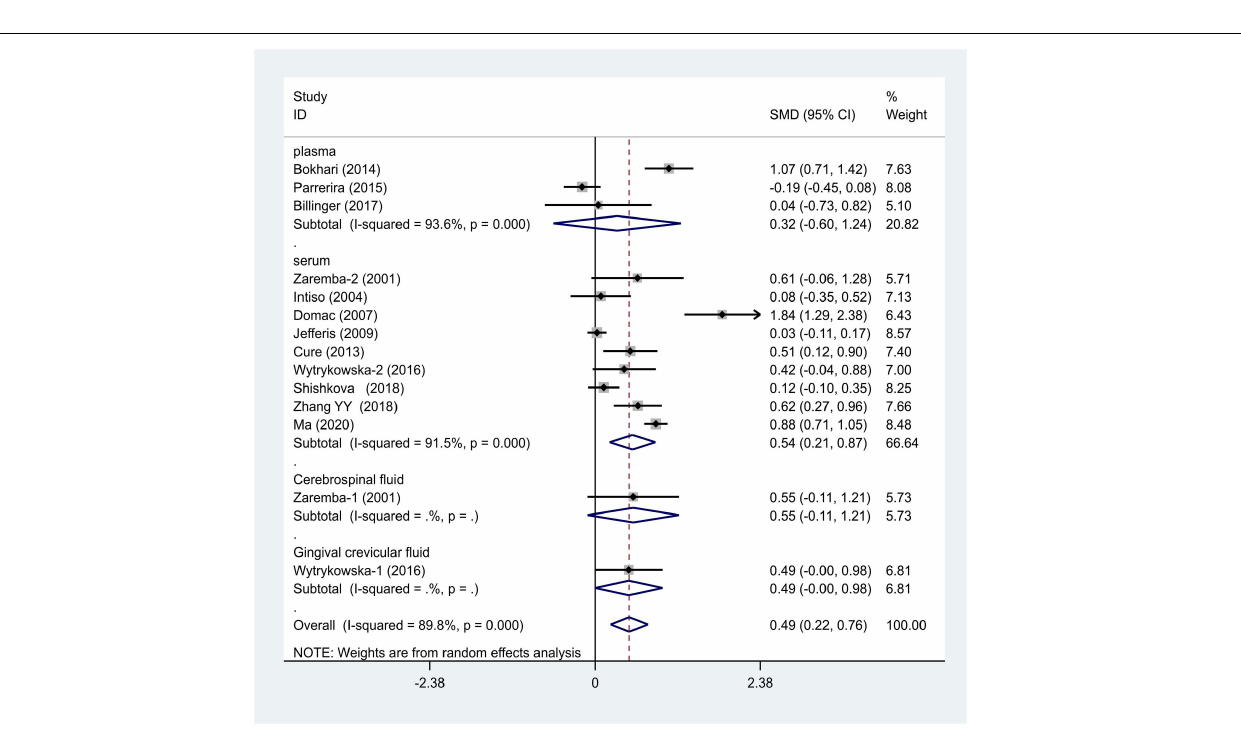
FIGURE 6 | Results of meta-analysis for the level of TNF- α and